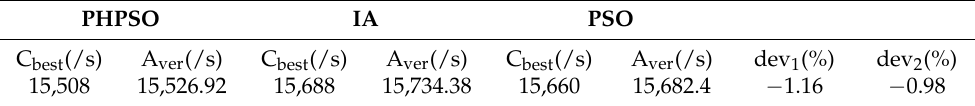
Table 5. Algorithm